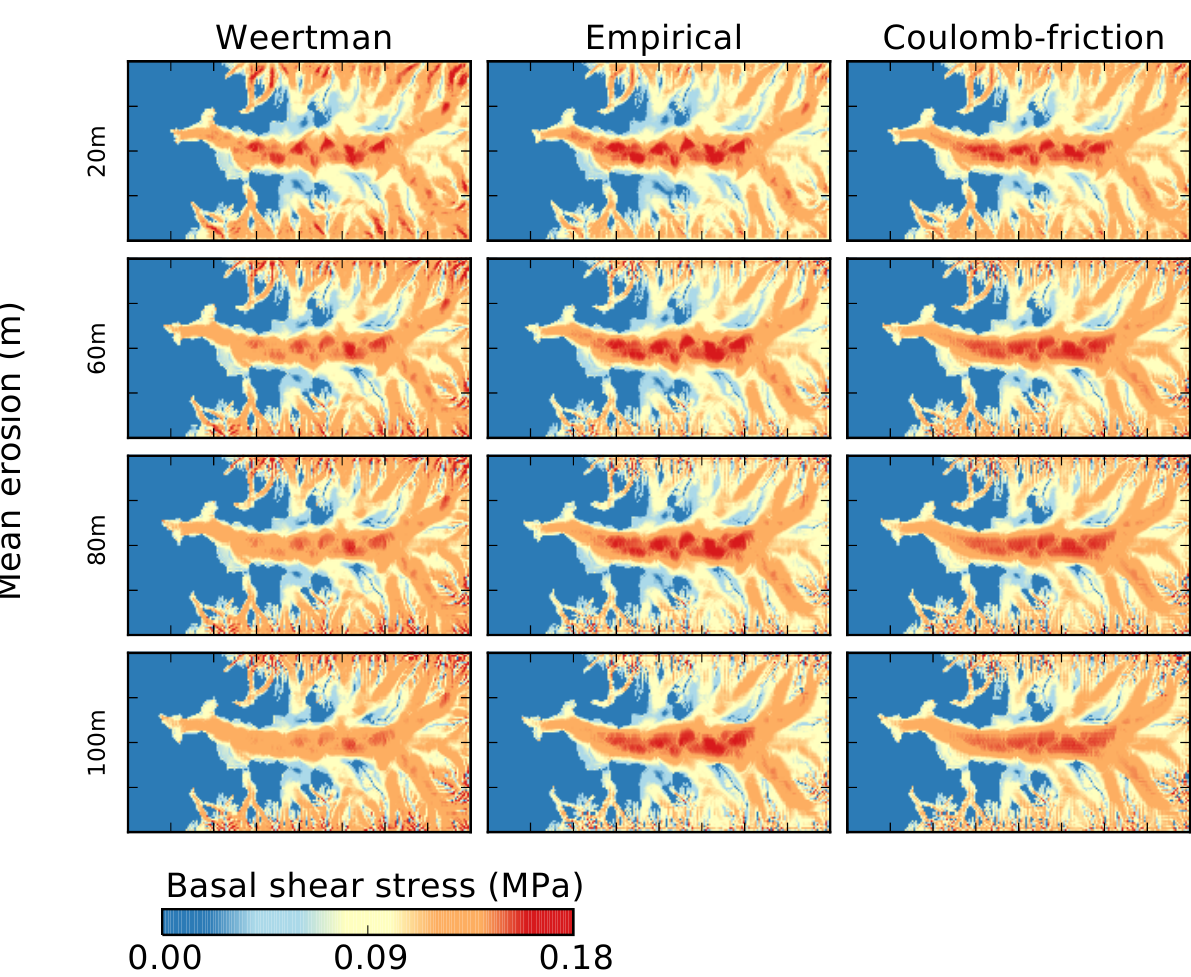
Figure 8. Results from experiment 3 using different sliding relations and m = 2 in Eq. (9). The three columns show basal shear stress for the different sliding laws: Weertman (Eq. 6), empirical (Eq. 7), and Coulomb friction (Eq. 8) at different stages of glacial